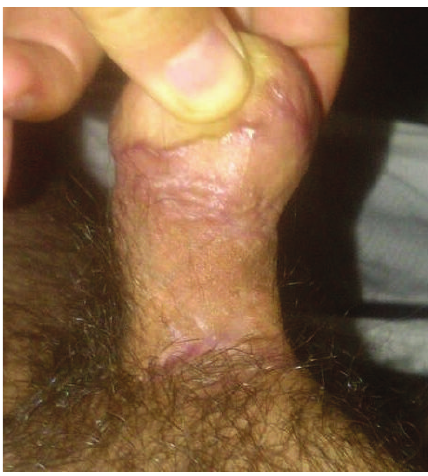
Figure 9: Ninety-day